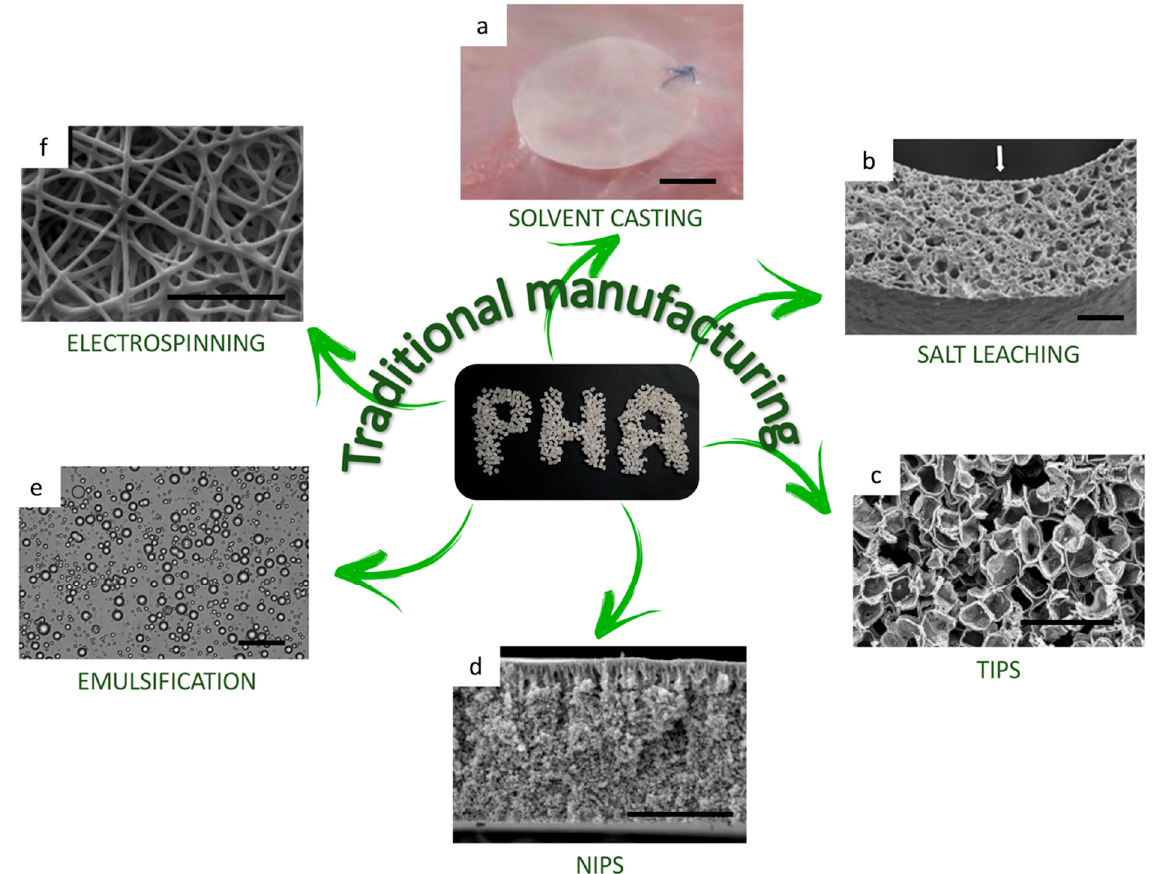
Figure 6. Morphology of PHA scaffolds produced with conventional techniques. ( a ) Visual appearance of a poly(3-hydroxybutyrate-co-3-hydroxyhexanoate), PHBH, film obtained via solvent casting (scale bar = 10 mm; adapted from Reference [93]). ( b ) SEM image of a PHBH conduit cross section with uniform wall porosity obtained via salt leaching; the white arrow indicates the internal side (scale bar = 100 μ m; adapted from Reference [81]). ( c ) SEM image of a porous scaffold made of a blend of PHB/PHBH obtained via thermally induced phase separation (TIPS) (scale bar = 500 μ m; adapted from Reference [94]). ( d ) SEM image of a PHBV membrane cross-section obtained via non-solvent-induced phase separation (NIPS) (scale bar = 50 μ m; adapted from Reference [95]). ( e ) Optical microscopy image of PHBH microspheres prepared via emulsification (scale bar = 50 μ m; adapted from Reference [96]). ( f ) SEM image of a porous PHBH film obtained via electrospinning (scale bar = 20 μ m; adapted from Reference [92]).